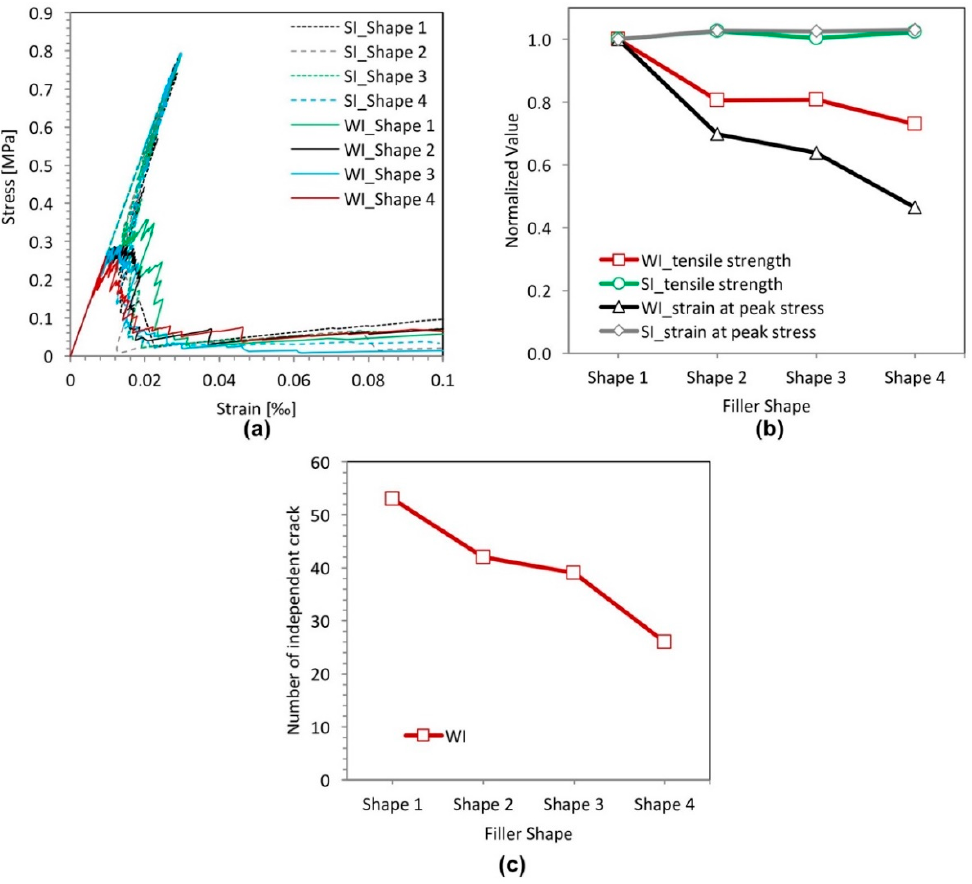
Figure 10. Simulated results of the filler shape effect analyses for specimens with a strong interface (SI) and a weak interface (WI). ( a ) Stress-strain relation; ( b ) variation of the strength and the strain at peak stress; ( c ) number of independent cracks.